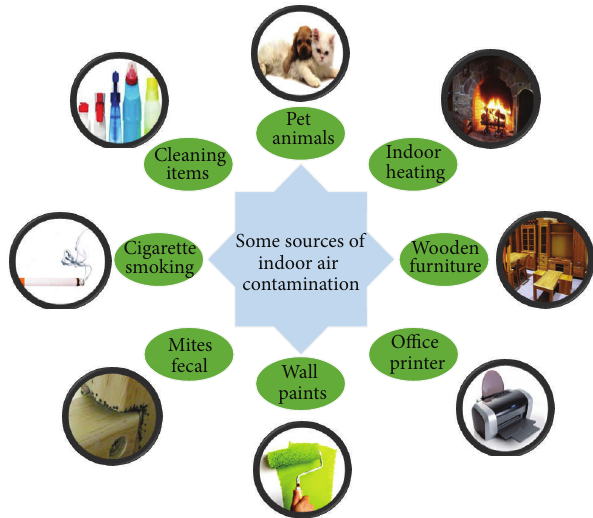
Figure 1: Some sources of indoor air contamination.